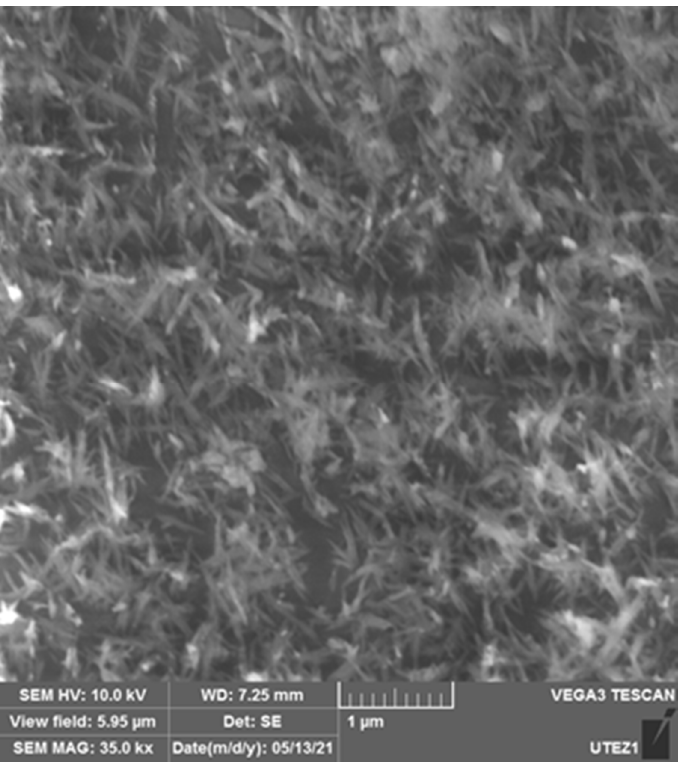
Figure 20. SEM image of the copper oxide film (CuO) deposited by the automated SILAR prototype using 10 cycles.